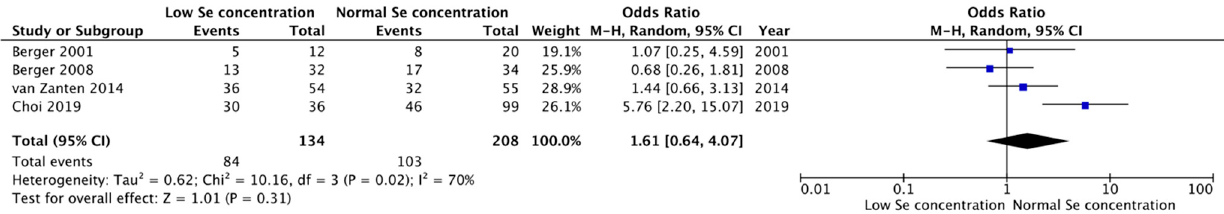
Figure 2. Forest plot of the impact of low serum Se concentration on mortality of patients with severe trauma.